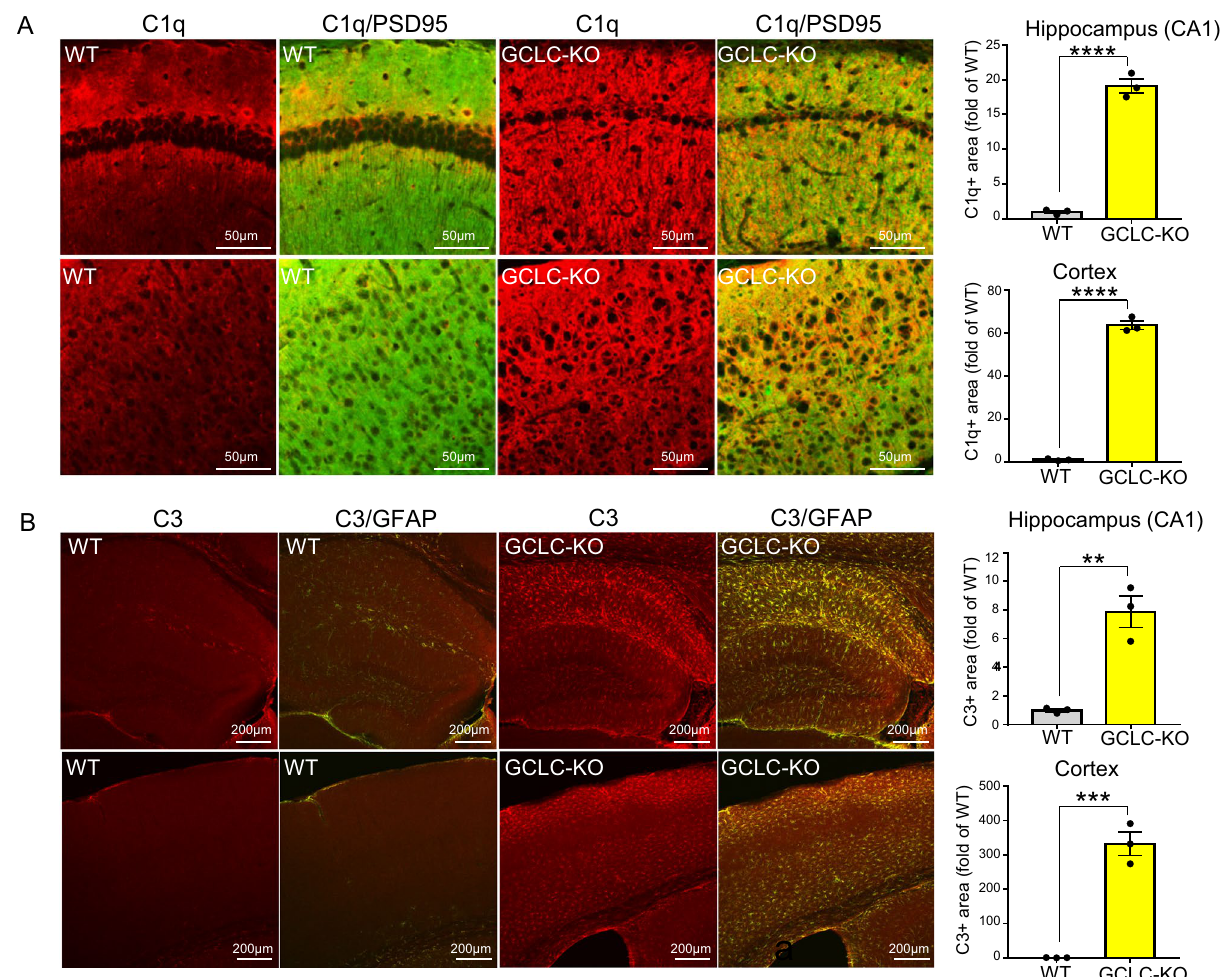
Figure 4. Complements are activated in GCLC-KO mouse brains. ( A,B ) Brain sections from 5-month-old WT (left panels) and GCLC-KO (right panels) were immunostained using C1q (Red) and PSD95 (neuronal cell marker) (Green) antibodies ( A ) or C3 (Red) and GFAP (Green) antibodies ( B ). Upper panels show the hippocampal CA1 region, and lower panels show the cortical region. Values shown in the graphs represent the mean intensity level ± SEM (n = 3; ** p < 0.01, *** p < 0.001, **** p <